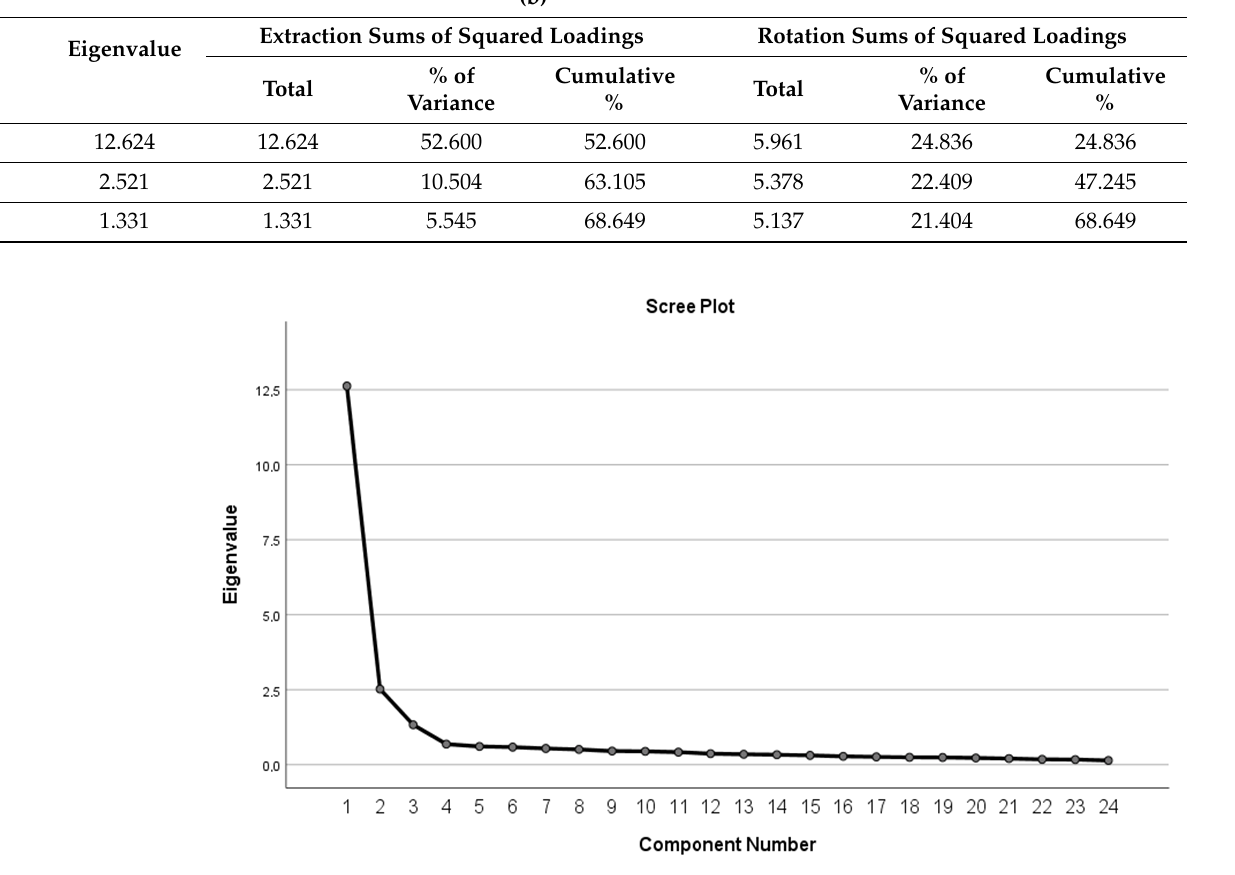
Figure 1. Scree plot of the extracted factors.